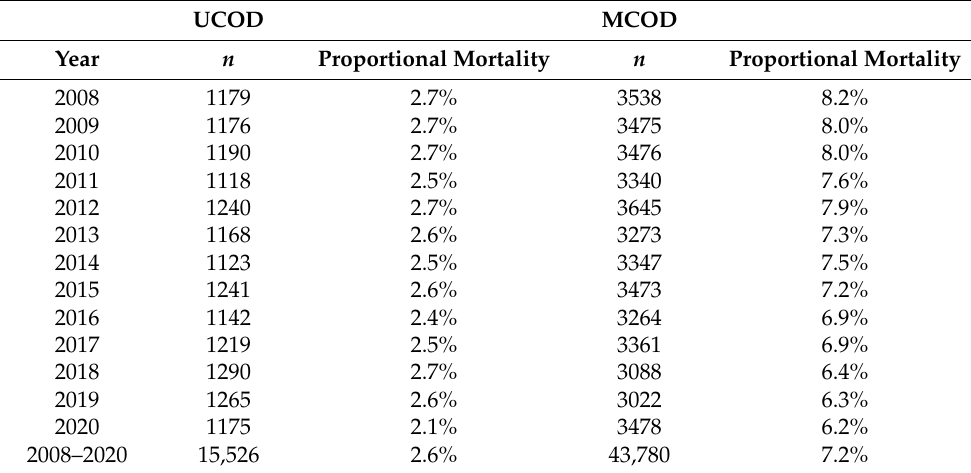
Table 1. Number of deaths from COPD selected as the underlying cause of death (UCOD) or mentioned anywhere in the death certificate (MCOD), and the corresponding share of all deaths (proportional mortality). Residents aged ≥ 40 years, Veneto region (Italy), 2008–2020. UCOD MCOD